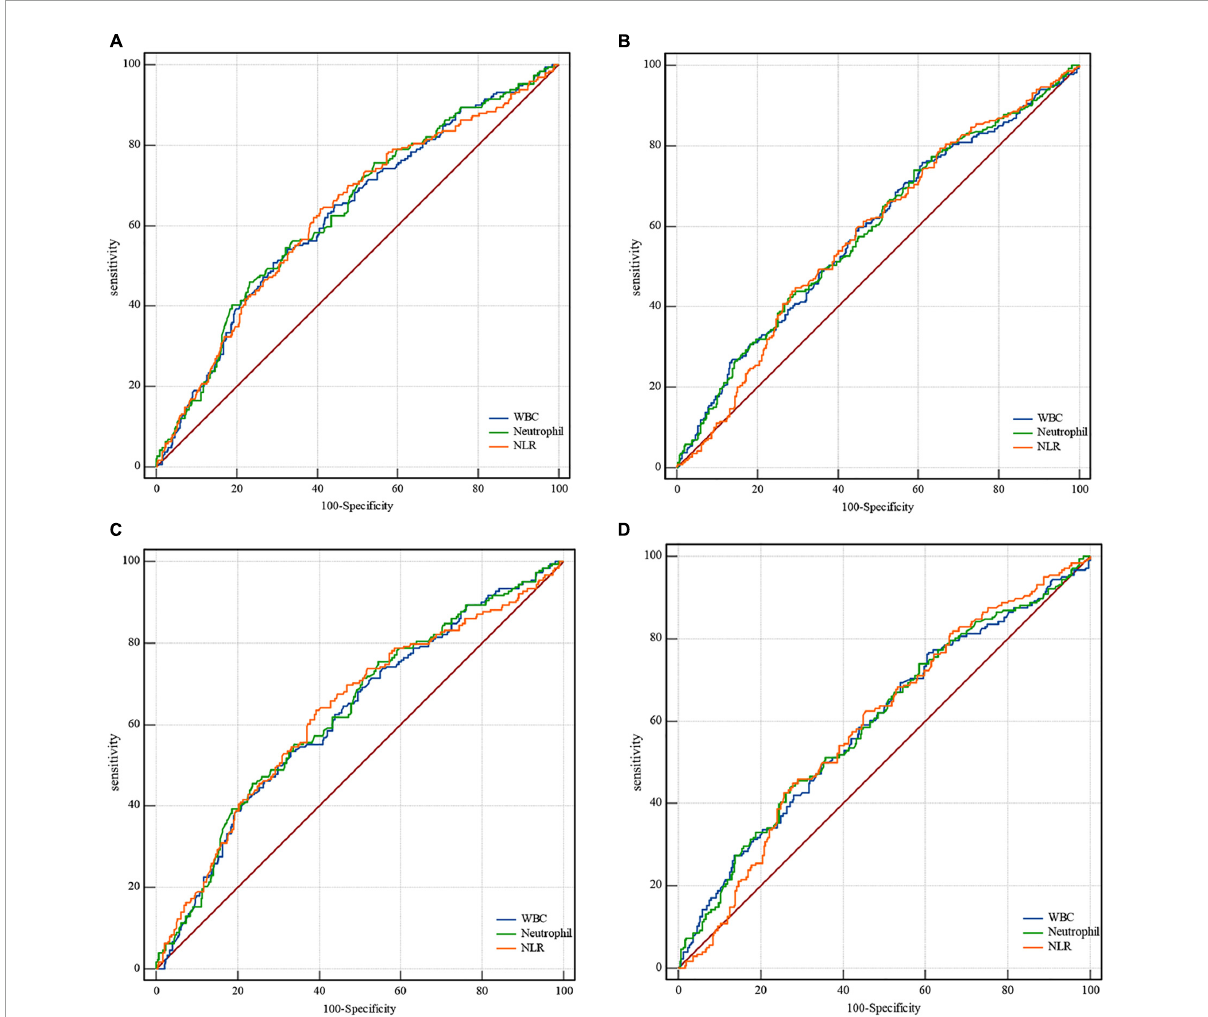
FIGURE1 Receiver operating characteristic curves for clinical outcomes. In all patients, the area under the curve for mRS 0–3 is (A) 0.627, confidence interval (CI) 0.59–0.67 for leukocytes; 0.634, CI 0.59–0.67 for neutrophils; 0.629, CI 0.59–0.67 for NLR. The area under the curve for mortality in all patients is (B) 0.587, CI 0.55–0.63 for leukocytes; 0.589, CI 0.55–0.63 for neutrophils; 0.580, CI 0.54–0.62 for NLR. In successfully recanalized patients, the area under the curve for mRS 0-3 is (C) 0.622, CI 0.58-0.67 for leukocytes; 0.630, CI 0.59–0.67 for neutrophils; and 0.630, CI 0.59–0.67 for NLR. The area under the curve for mortality in these patients is (D) 0.594, CI 0.55-0.64 for leukocytes; 0.597, CI 0.55–0.64 for neutrophils; and 0.591, CI 0.55–0.64 for NLR. mRS, modified Rankin Scale; CI, confidence interval; NLR, neutrophil-to-lymphocyte